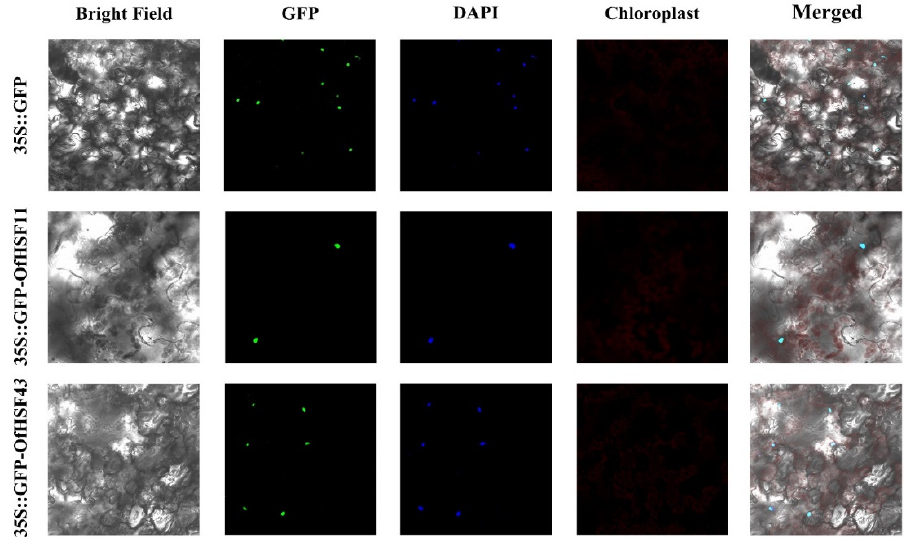
Figure 8. Subcellular localizations of OfHSF11 and OfHSF43 . GFP represents the vector control. staining was used to mark the positions of DAPI staining was used to mark the positions of nuclei.